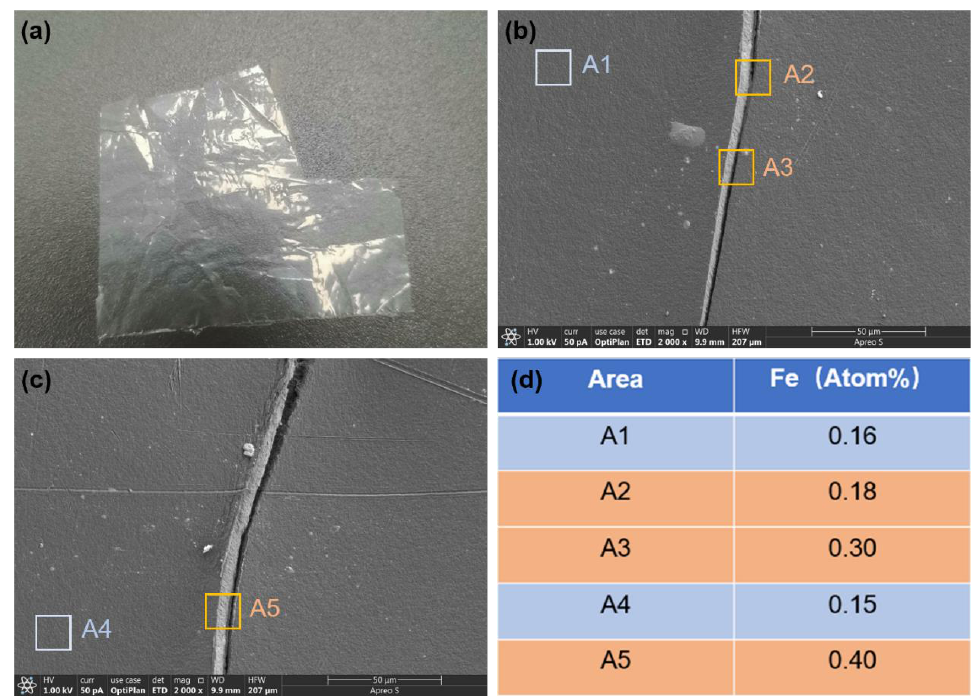
Figure 10. ( a ) Picture of PE-0.9 film after 72 h UV irradiation; ( b ) and ( c ) pictures of cracks; ( d ) the relative atomic content of Fe element.